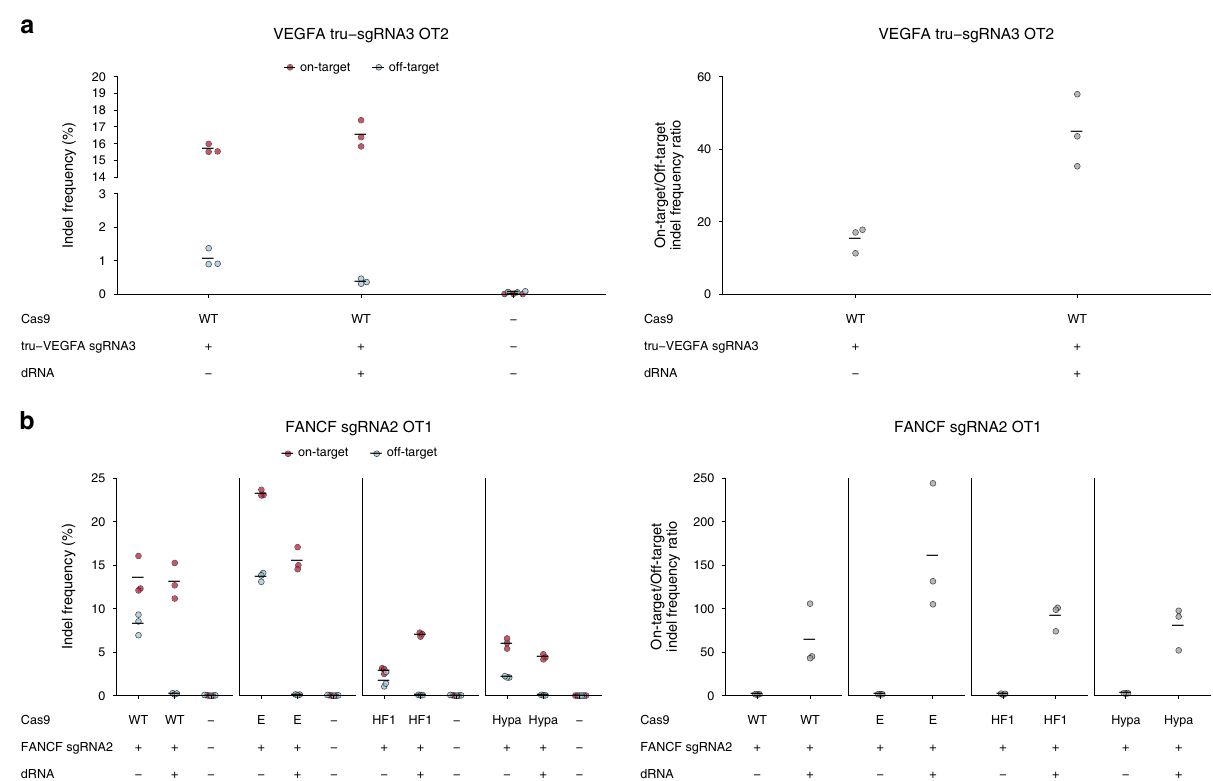
Fig. 4 dRNAs can be combined with other approaches for improving Cas9 speci fi city. Indel frequencies and speci fi city ratios 24 h after transfection